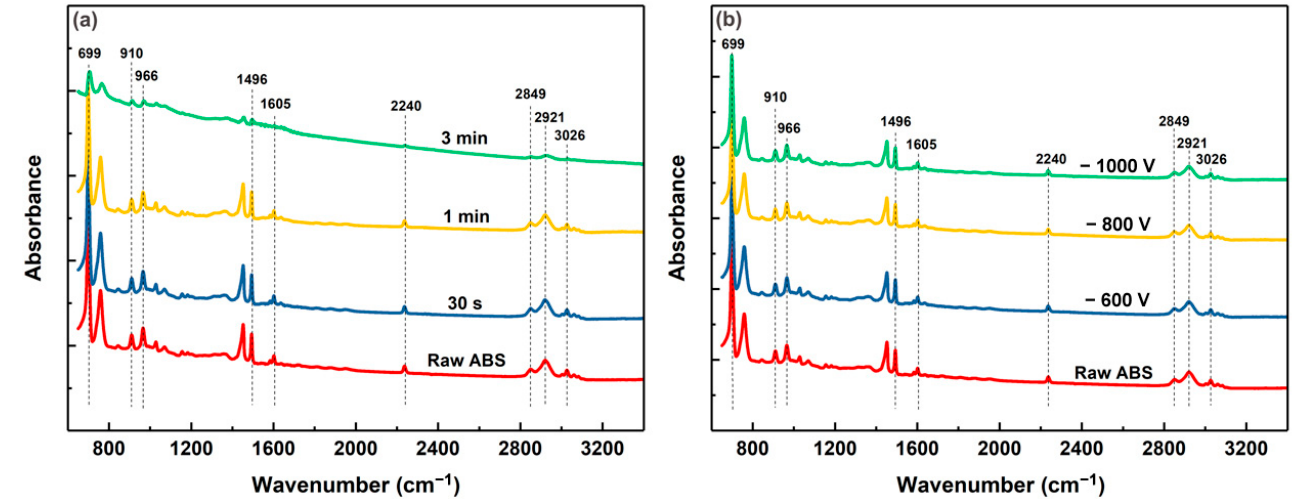
Figure 4. FTIR spectra of the raw ABS and the ABS substrates treated by Cr ions with different duration at bias voltage of 400 V ( a ) and by Cr ions with different bias voltages for 30 s ( b ). It can be seen that the intensity of all the characteristic peaks in the FTIR spectra decrease with the increasing treatment duration of the Cr ion bombardment, as shown in Figure 4a. This indicates that the chemical bonds of the ABS surface indeed deteriorate with Cr ion bombardment. However, with the same treatment duration of 30 s of the Cr ion bombardment, the FTIR spectra of the samples show little change with increasing bias voltage (see Figure 4b), implying that the bombardment energy of the Cr ions has little influence on the chemical bonds of the ABS. It is believed that heat accumulation due to the continuous bombardment by Cr ions may play a major role in the surface deterioration of the ABS